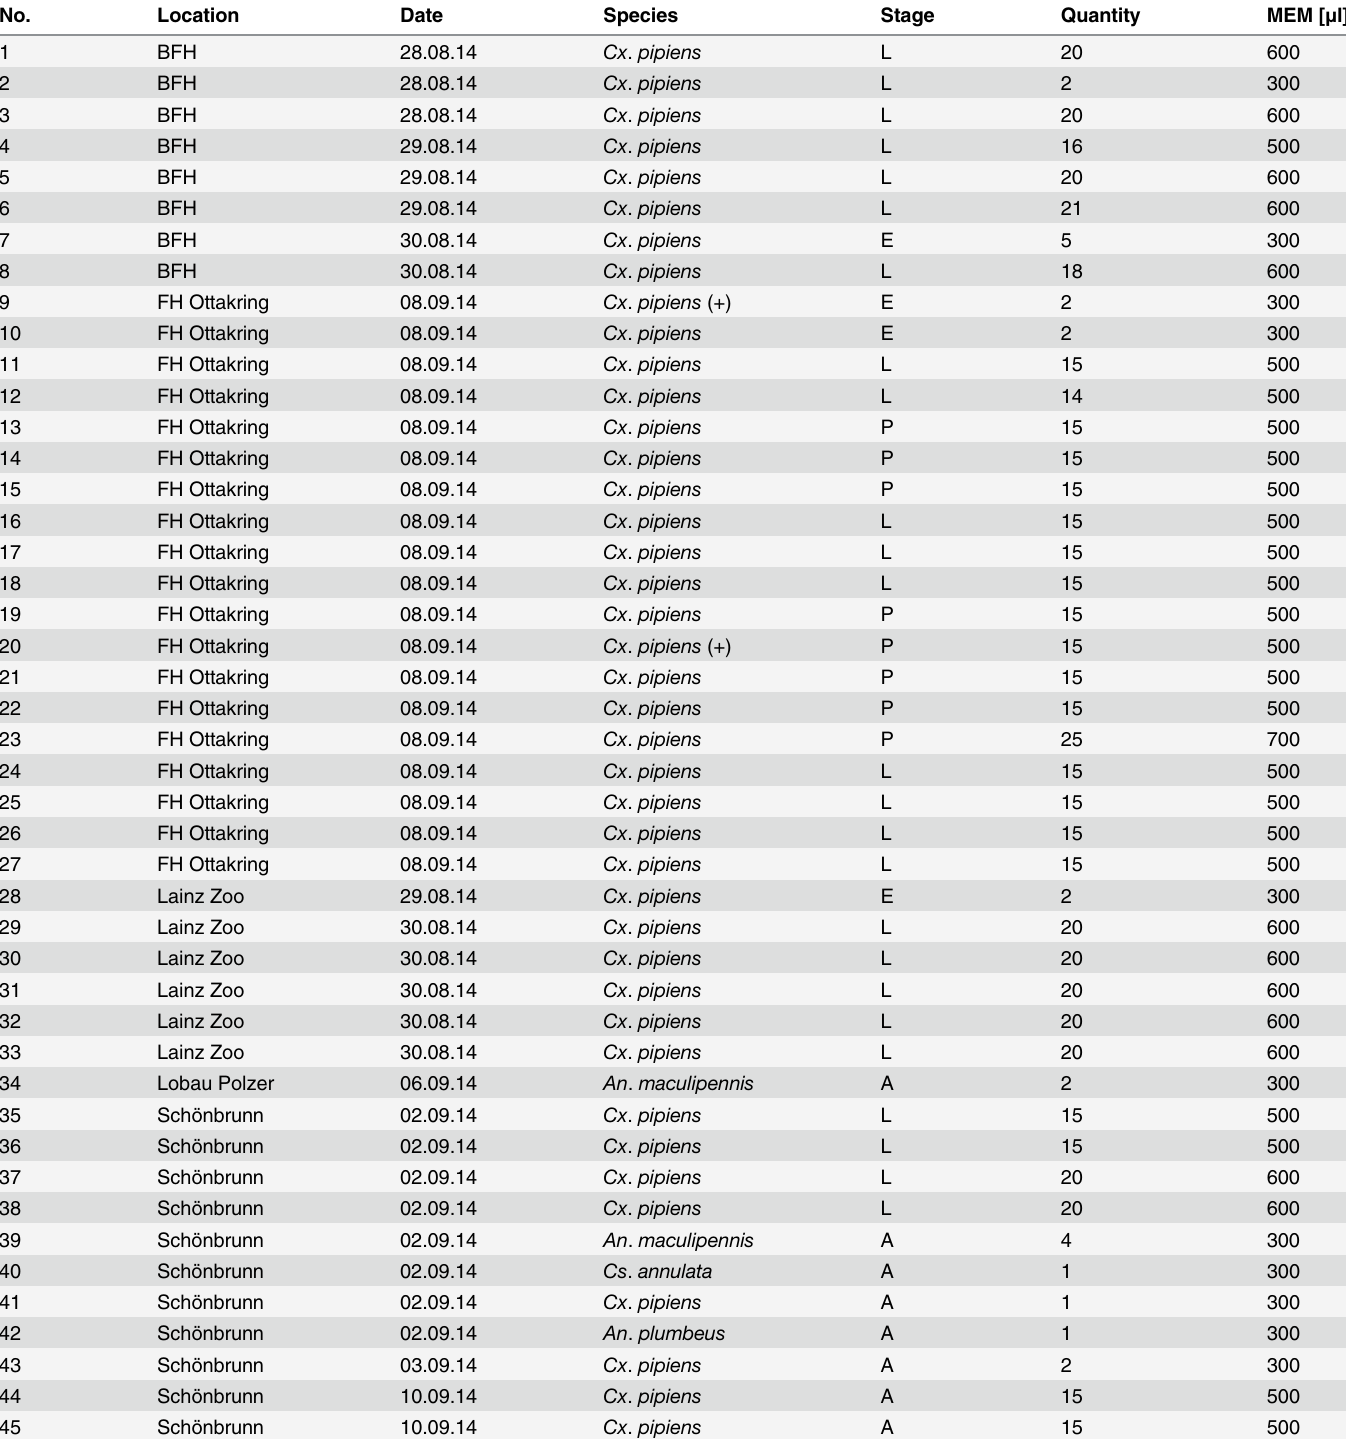
Table 1. Mosquitoes collected in the city of Vienna between 28 August and 10 September